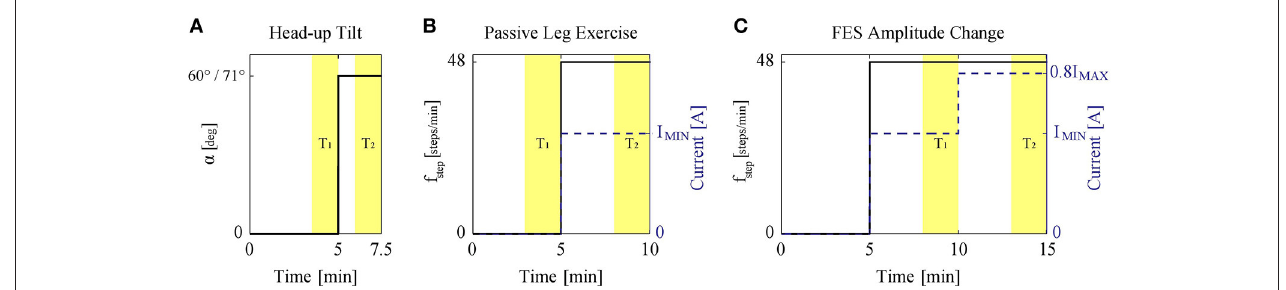
FIGURE 2 | (A) Study protocol 1: head-up tilt to 60 ◦ and 71 ◦ (two experiments). (B) Study protocols 2 and 3: PE at 48steps/min (solid) without or with application of the minimum FES amplitude (dashed). The protocols were conducted at α 20 ◦ ,40 ◦ ,60 ◦ . The figure shows the experiment performed at each specific tilt angle. = { } (C) Study protocol 4: during PE at 48 steps/min (solid) with FES, the FES amplitude (dashed) was changed to a higher level, i.e., 0.8I MAX . The protocol was conducted at α 0 ◦ ,20 ◦ ,40 ◦ ,60 ◦ . The figure shows the experiment performed at each specific tilt angle. The highlighted areas T 1 and T 2 show the data range = { } used for the